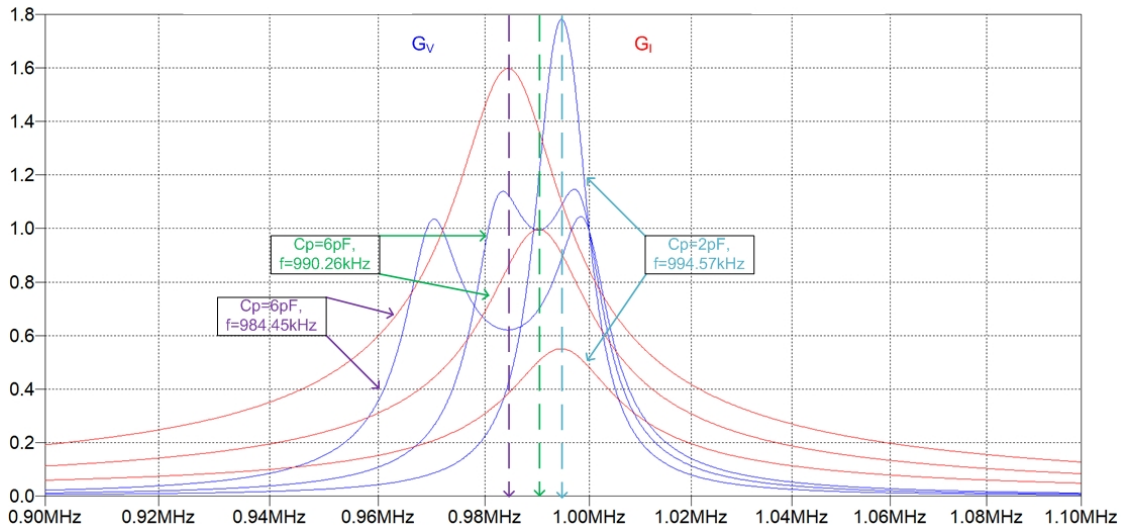
Figure 13. G V and G I behavior.